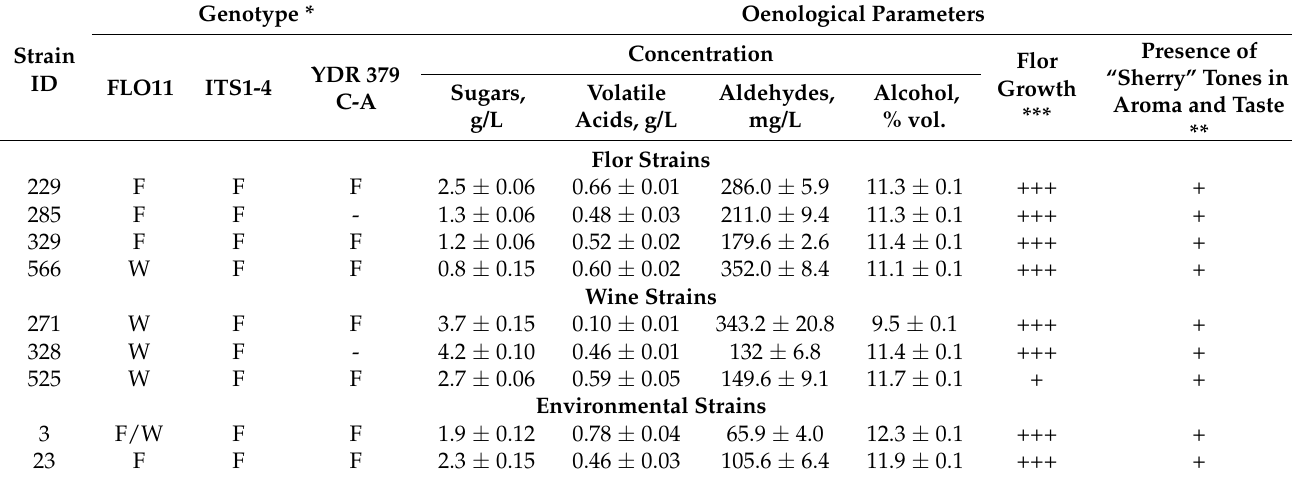
Table 1. Genetic and oenological characteristics of S. cerevisiae